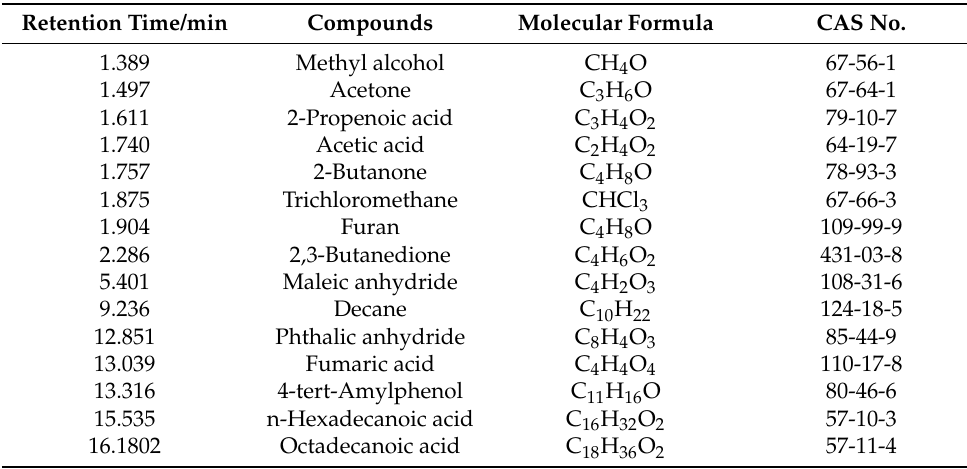
Table 5. Pyrolysis products retrieved by